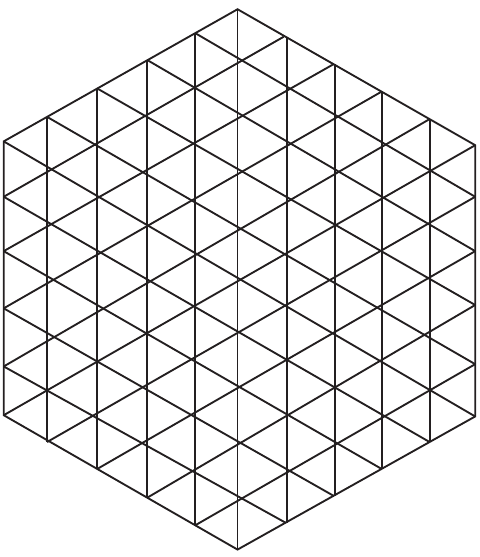
Figure 11: For n � 6, hexagonal network HX